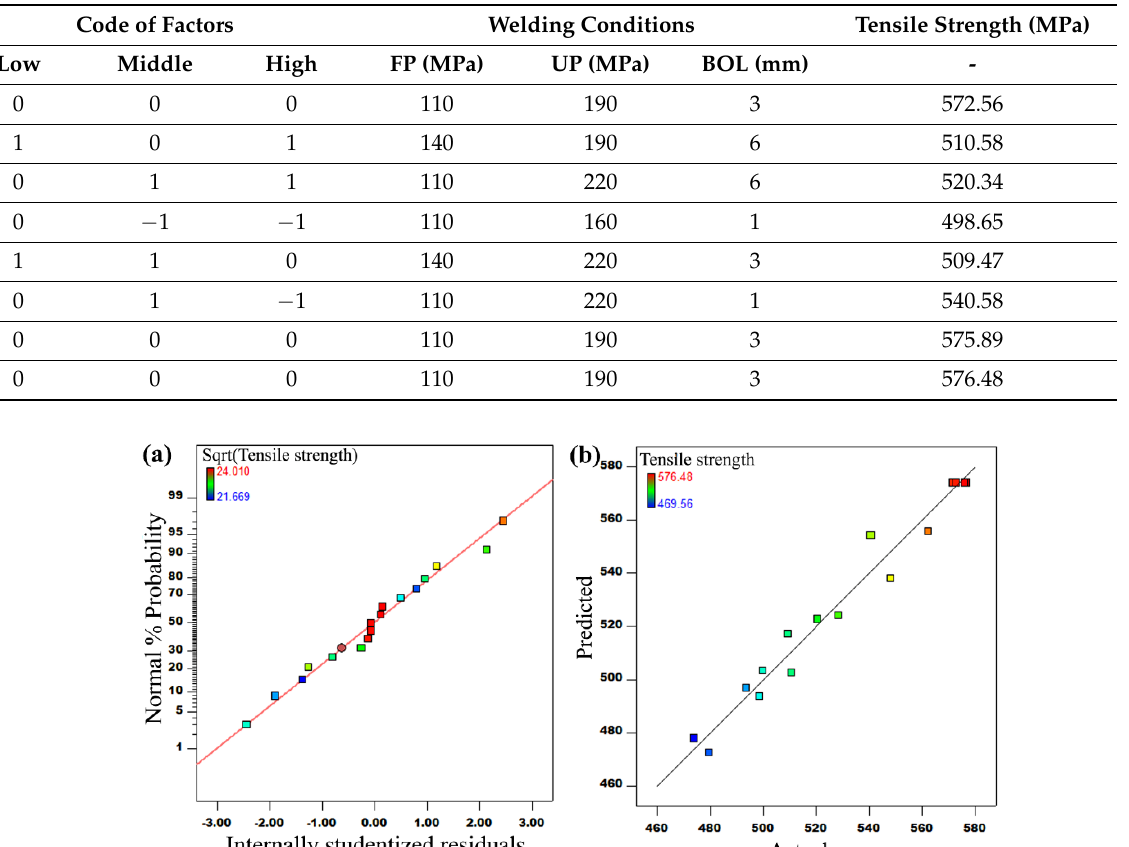
Figure 2. The linear graphs shows the developed response model accuracy conditions ( a ) Normal plot of residuals, ( b ) predicted and experimental values comparison.